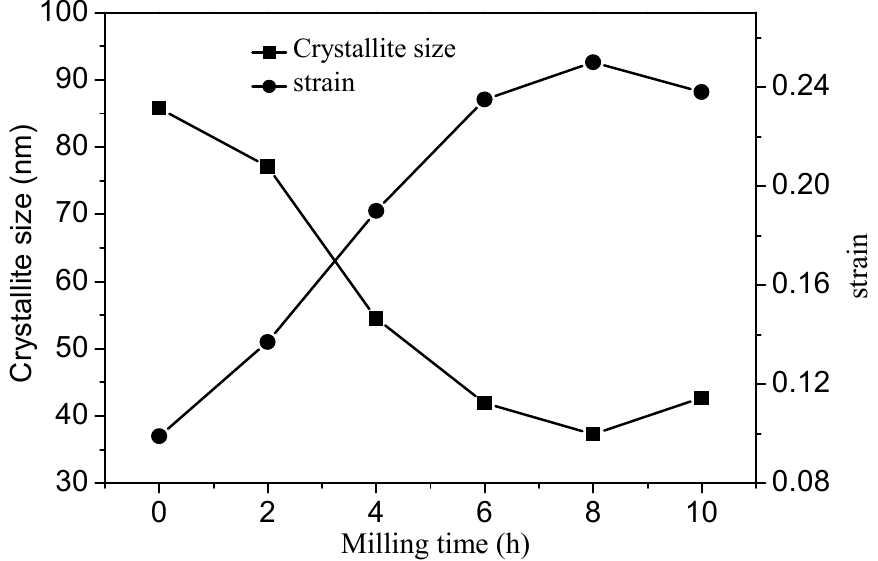
Figure 6. Variation in the crystallite size and strain with milling time.